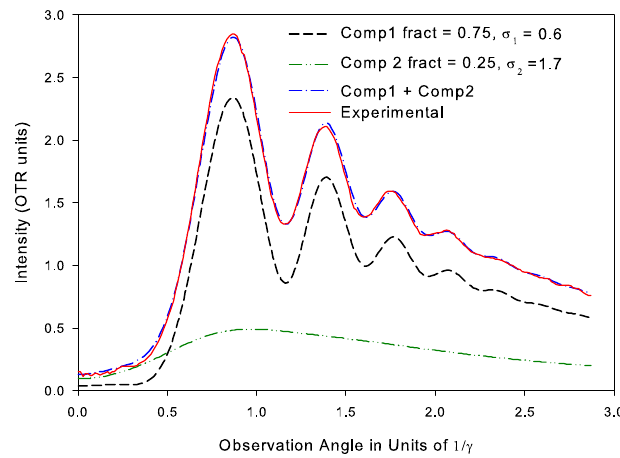
FIG. 10. (Color) Comparison of the effect of single Gaussian distribution functions with different rms widths on the OTRI fringes (left); expanded plot region (right).